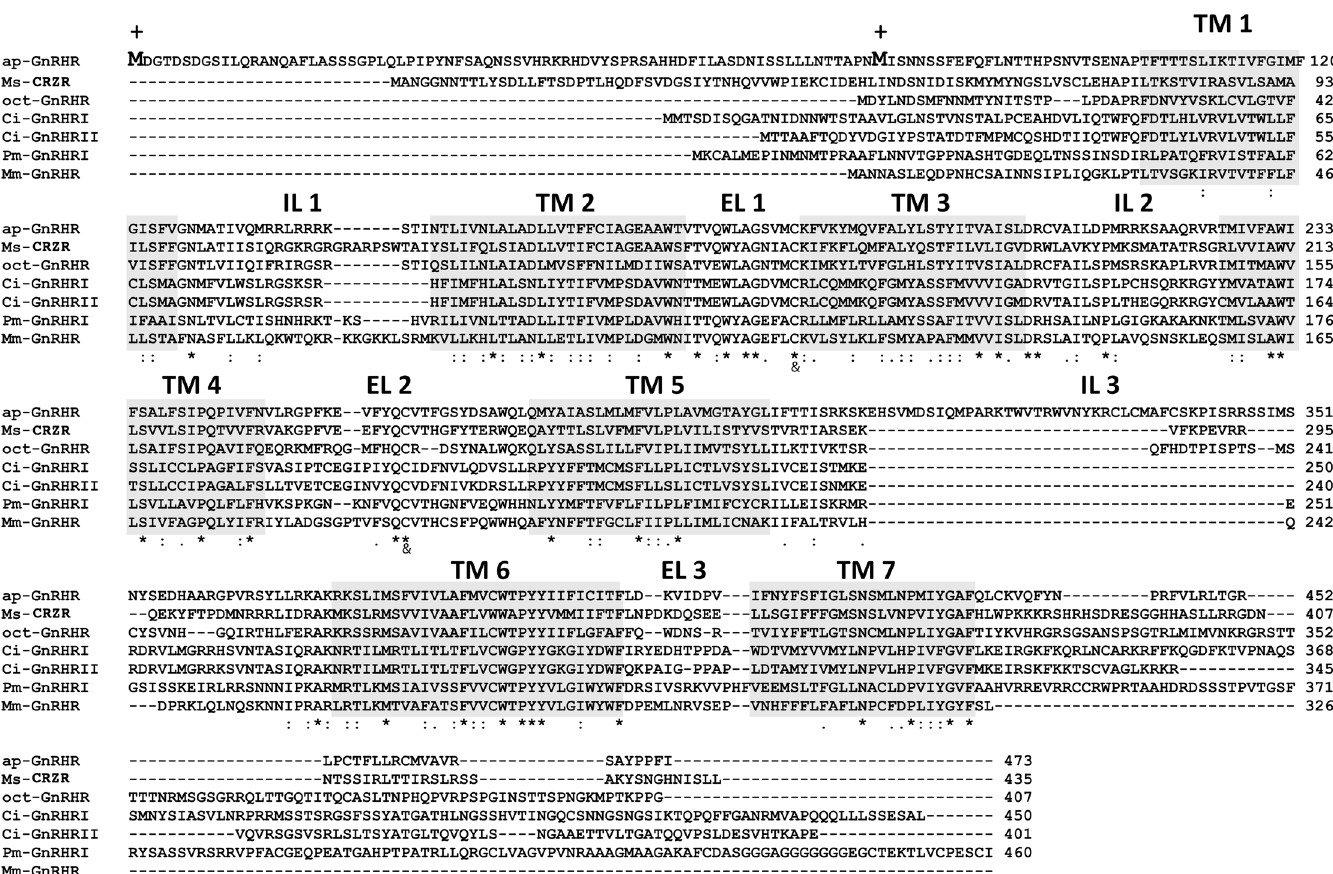
Fig 2. Amino acid sequence alignment of ap-GnRHR with representative GnRHR-related receptors. Shaded amino acids indicate the transmembrane (TM) domains. The predicted intracellular loops (IL) and extracellular loops (EL) are numbered accordingly. The two putative start sites (M) are each denoted by a “ + ” . Ms-CRZR — corazonin receptor, Manduca sexta (AAR14318); Oct-GnRHR — Gonadotropin-releasing hormone receptor, Octopus vulgaris (GNRHR_OCTVU); Ci-GnRHRI — gonadotropin-releasing hormone receptor 1, Ciona intestinalis (NP_001028997); Ci-GnRHRII — gonadotropin-releasing hormone receptor 2, Ciona intestinalis (NP_001028996); Pm-GnRHRI — gonadotropin releasing-hormone receptor, Petromyzon marinus (AF439802_1); Mm-GnRH — gonadotropin-releasing hormone receptor isoform Mus musculus (NP_001297580). Identical, highly conserved, and less conserved amino acid residues are denoted by an asterisk ( * ), a colon (:), and a period (.), respectively. Ampersand (&) denotes cysteine residues involved in the disulfide bridge